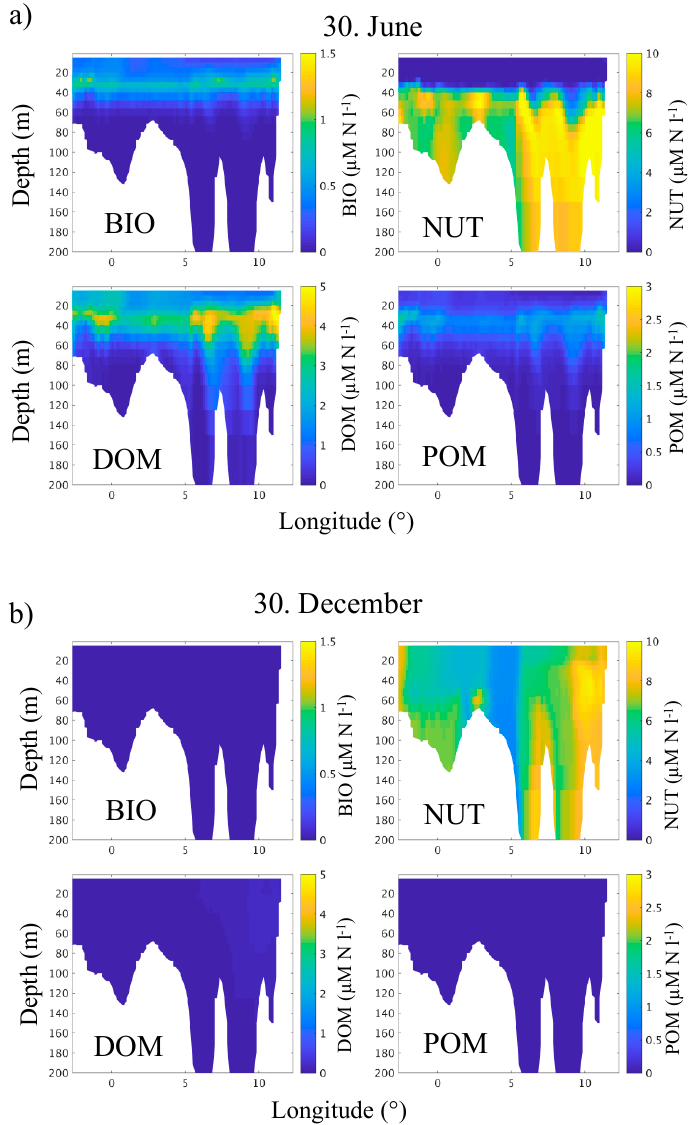
Figure 5. Vertical distribution along transect 1 (58 ◦ N see Figure 1) of the variables BIO, DOM, NUT, POM in June ( a ) and December ( b ), as estimated in the biogeochemical module OxyDep. The simulated horizontal and vertical distribution of total PCB (particulate and dissolved,